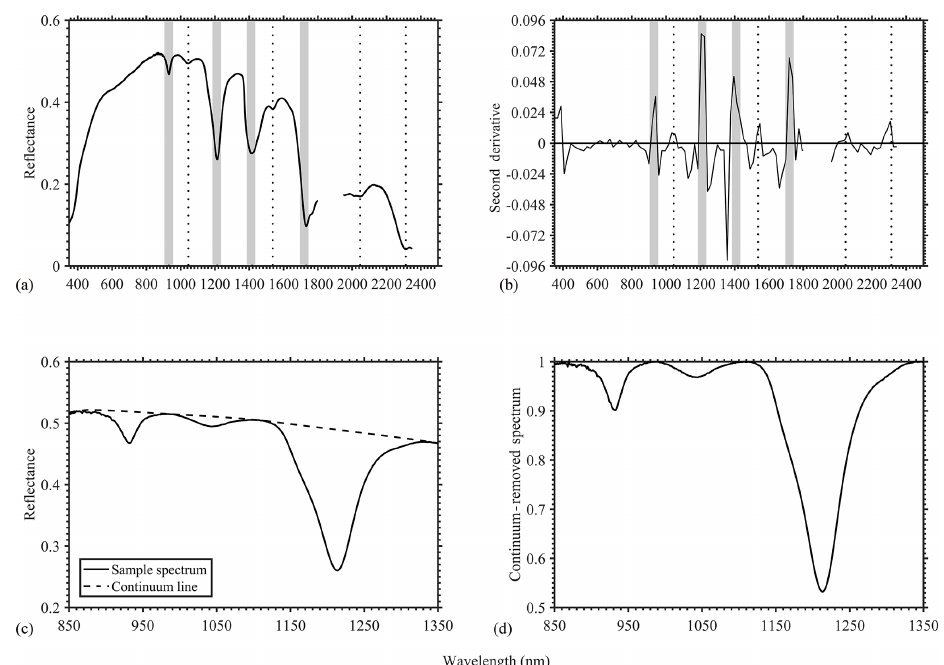
Figure 2. (a) Example spectral reflectance used for visual inspection to identify absorption features highlighted by the vertical lines, (b) second derivative signal validating the location of absorption features, (c) continuum line generated from the convhull function and (d) continuum-removed